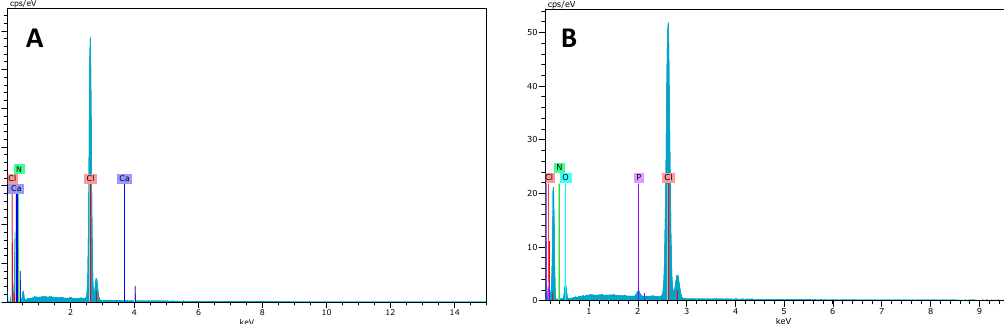
Figure 5. SEM of membranes containing 30% w / w of IL after being used as separators for each feeding solution: CaCl 2 ( A ) and Na 2 HPO 4 ( B ), and elemental mapping: CaCl 2 ( A’ ) and Na 2 HPO 4 ( B’ ). Processes 2018 , 6 , x FOR PEER REVIEW